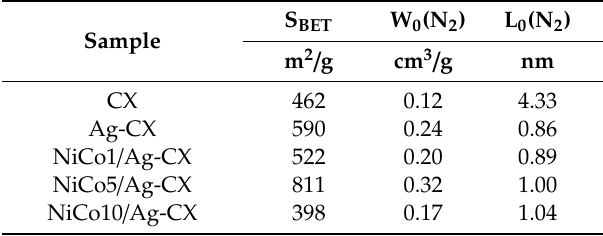
Table 1. Textural characteristics of the samples.